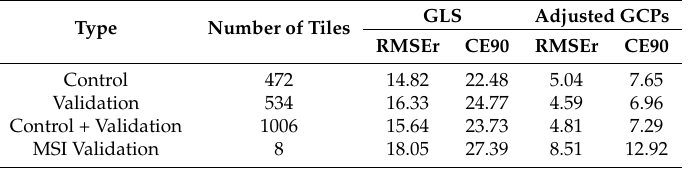
Table 10. Validation results for the Americas block using Image-to-Image characterization between the Sentinel-2 GRI tiles and Landsat 8 L1T products that were processed before (GLS) and after (Adjusted GCPs) bundle